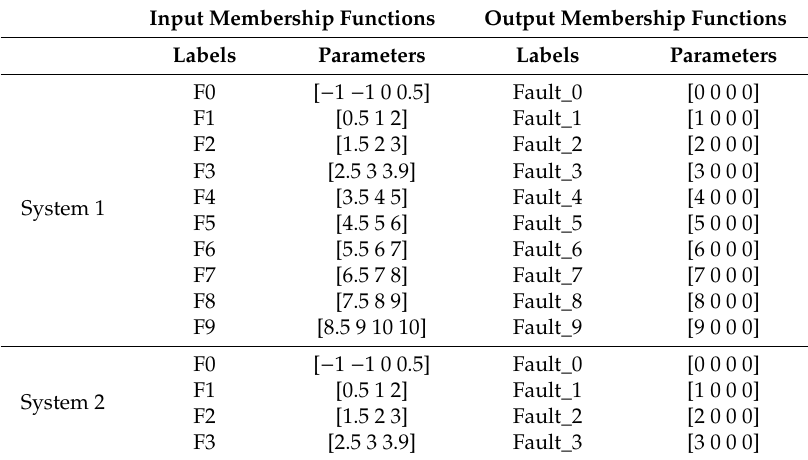
Table 8. Fuzzy classifier input and output membership functions.